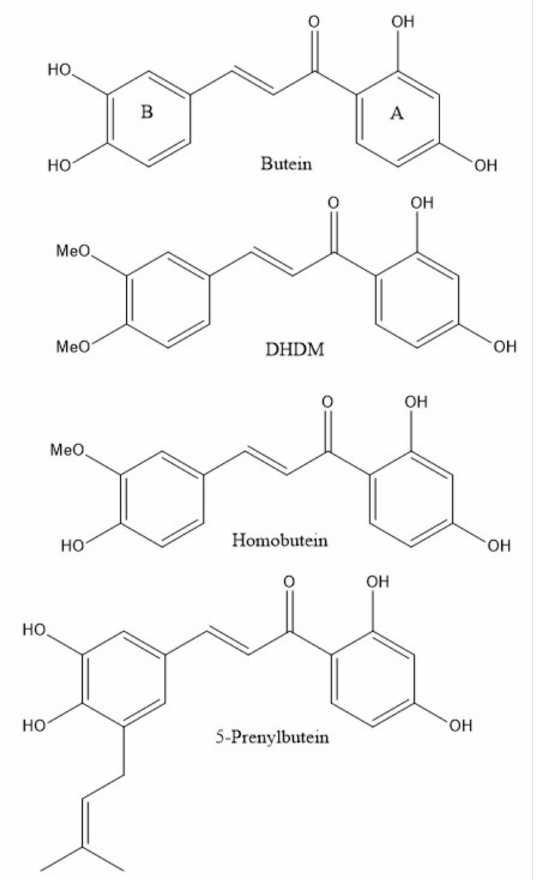
Figure 1. The 2D chemical structures of studied 2 (cid:48) ,4 (cid:48) -diOH chalcones, ( 1 ) Butein, ( 2 ) DHDM, ( 3 ) Ho- mobutein, and ( 4 ) 5-Prenylbutein. The substituent variation in these compounds is only in ring B, shown on the left of each